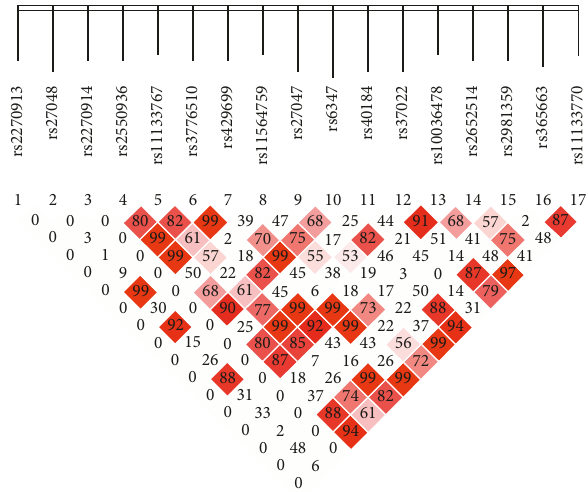
Figure 1: Linkage disequilibrium plots for the 3